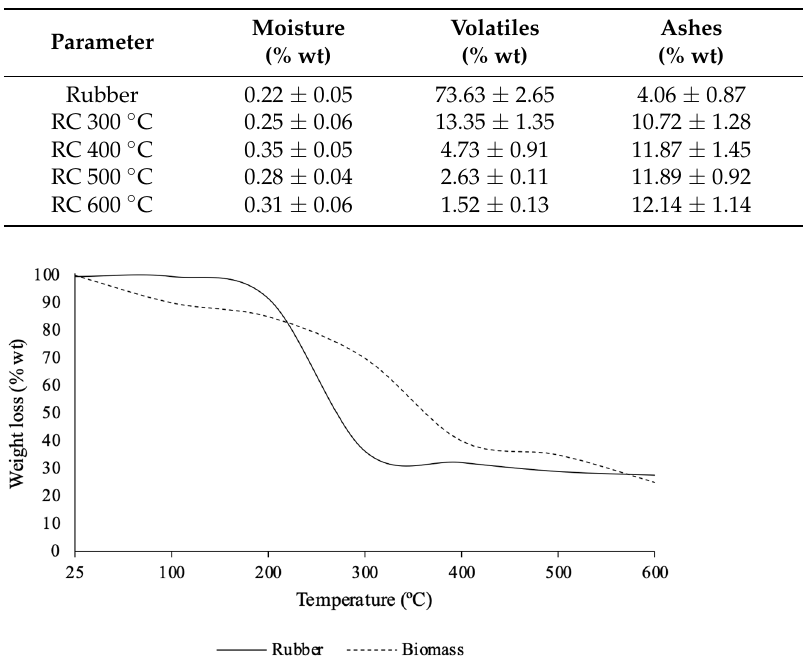
Table 4. Results of the proximate analysis carried out on the carbonized rubber (RC) samples obtained in this study. The values represent the mean ± standard deviation.